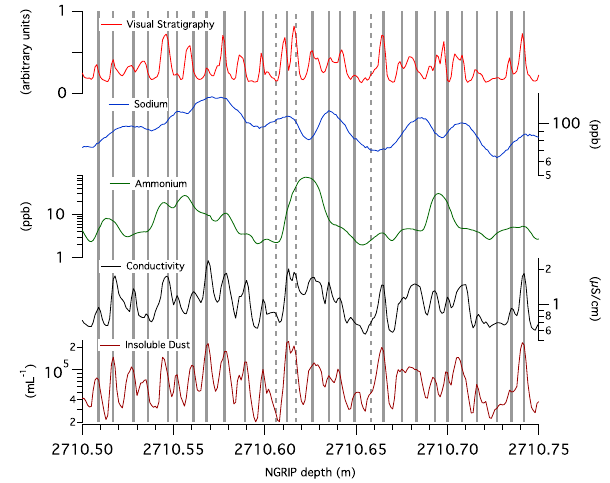
Fig. 2. Example of Continuous Flow Analysis (CFA) measurements of NorthGRIP glacial ice and assignment of annual layers. Visual stratigraphy was measured by optical scanning at the drilling site, not by CFA. Vertical gray bars indicate “certain” (solid line) and “uncertain” (dotted line) years. Note that sodium, ammonium, con- ductivity and insoluble dust are plotted on logarithmic